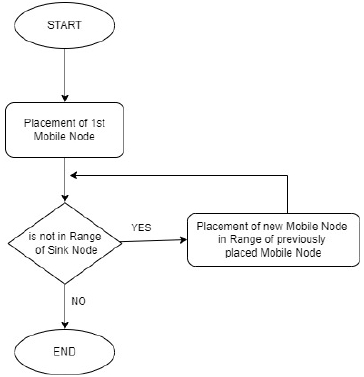
Figure A2. Direct MobileCC